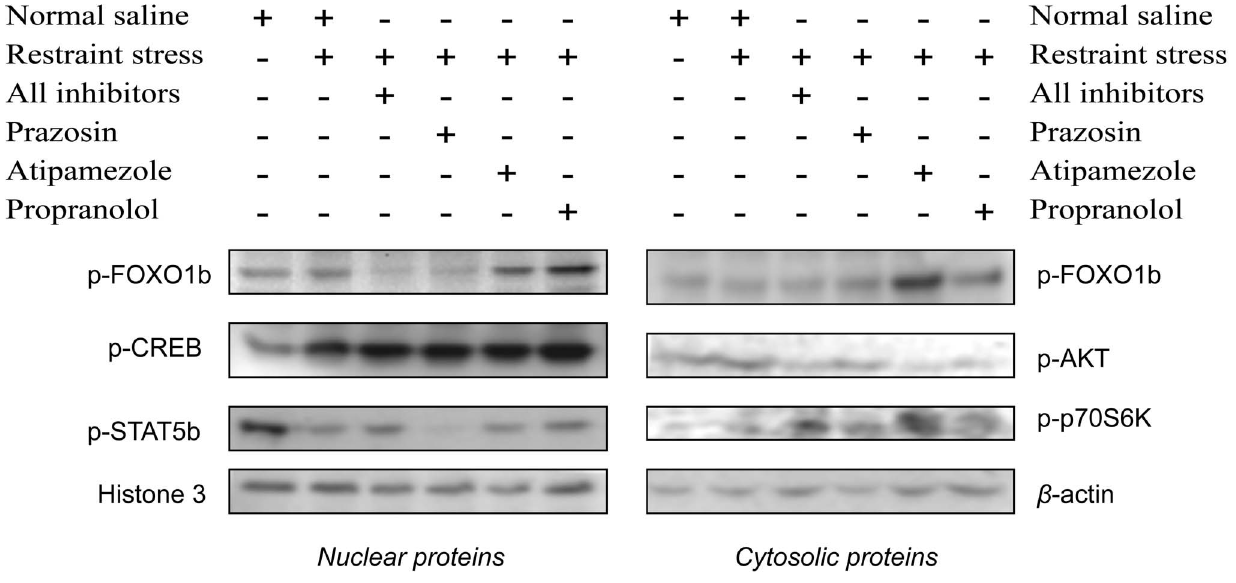
Figure 3. Stress-induced effect on PI3K/AKT, cAMP/PKA/CREB and GH/STAT5b signaling pathways. The evaluation of the stress effect on theses pathways was conducted in nuclear and cytosolic proteins with Western blot. Histone H3 served as a loading control for nuclear proteins and b -actin for cytosolic proteins. AR: adrenergic receptor; AR-antagonists given prior to stress inhibited a 1 -, a 2 - and beta-AR signaling; prazosin ( a 1 - AR ainhibitor), atipamezole ( a 2 -AR inhibitor), propranolol ( b -AR